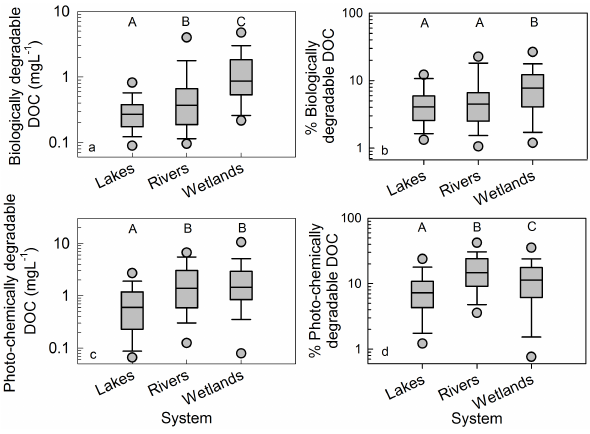
Figure 2. Amounts and proportions of biologically and photochem- ically degradable DOC across the three main types of systems stud- ied. Lines represent the 25, 50 and 75 percentiles, points, 5 and 95 percentiles. Different letters denote statistically different ( p < 0 . 01) means across groups, based on ANOVA (analysis of variance) and Tukey–Kramer post hoc analyses. BDOC (percent and absolute): n = 201 for lakes, n = 71 for rivers, n = 53 for wetlands. PDOC (percent and absolute): n = 193 for lakes, n = 136 for rivers, n = 67 for wetlands.